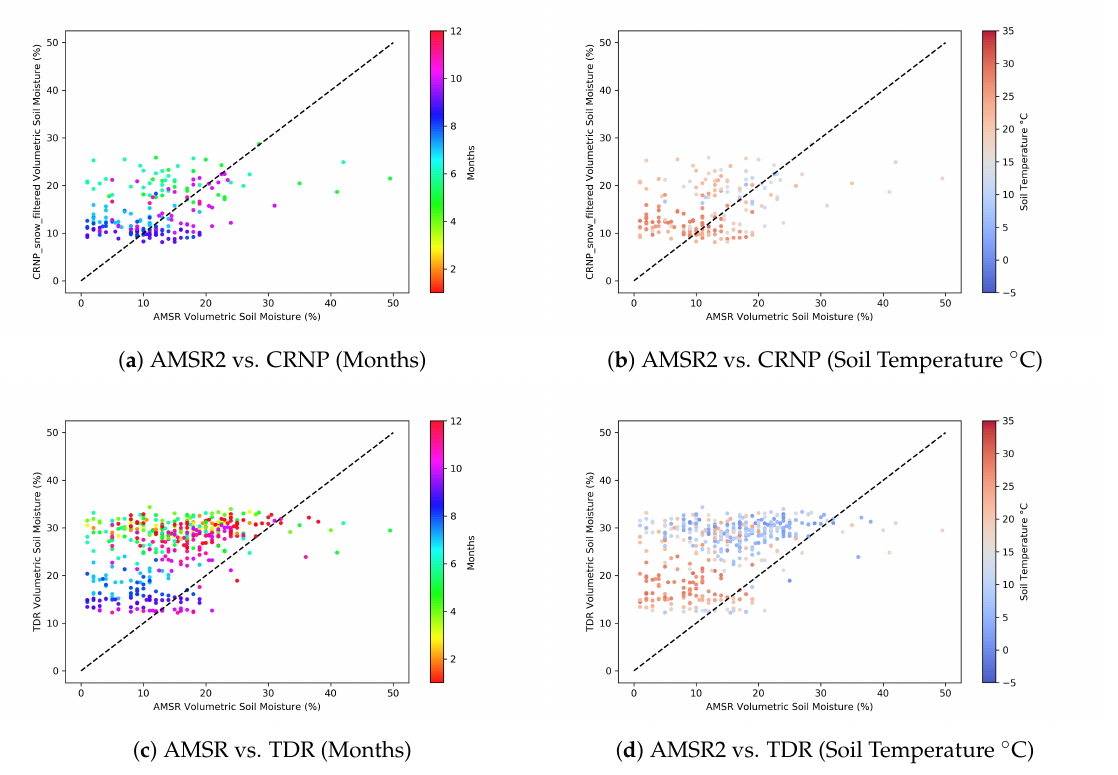
Figure A1. Comparisons between AMSR2 Soil Moisture Product with CRNP and TDR.